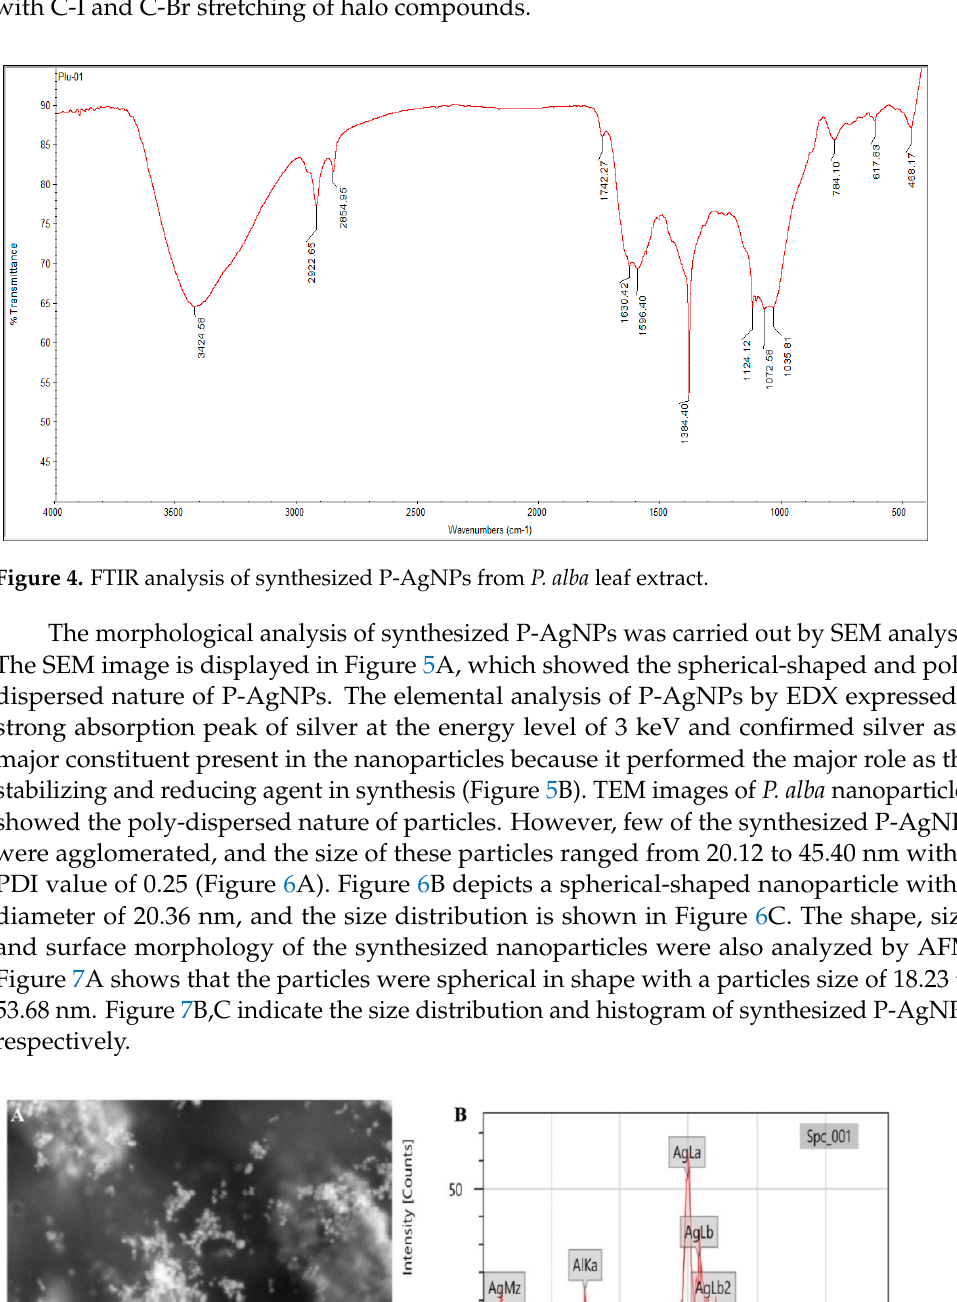
Figure 6. TEM Analysis of Synthesized P-AgNPs from P.alba leaf extract. ( A ) Polydispersed AgNPs, ( B ) Single spherical-shaped AgNP and ( C ) P-AgNPs’ histogram showing size distribution. Figure 7. AFM analysis of synthesized P-AgNPs from P.alba leaf extract. ( A ) Two dimensional de- piction, ( B ) size distribution, and ( C ) histogram. The crystalline nature and composition of AgNPs and the phase purity of synthe- sized P-AgNPs were analyzed by XRD. The XRD graph (Figure 8) shows specific Bragg reflections with 2 θ values at 111, 200, 220, and 311, which correspond to 38.08°, 44.18°, 64.41°, and 77.35°, respectively, in the JCPDS database of silver. These lattice plane values confirm the face-centered cubic crystalline nature of the synthesized P-AgNPs. The aver- age particle size was 26.43 nm as calculated by Scherr’s equation. The surface charge po- tential and stability of the nanoparticle in the aqueous suspension were analyzed by the zeta potential. The zeta potential of synthesized P-AgNPs showed a sharp peak at − 24.6 mV (Figure 9) and confirmed good stability.